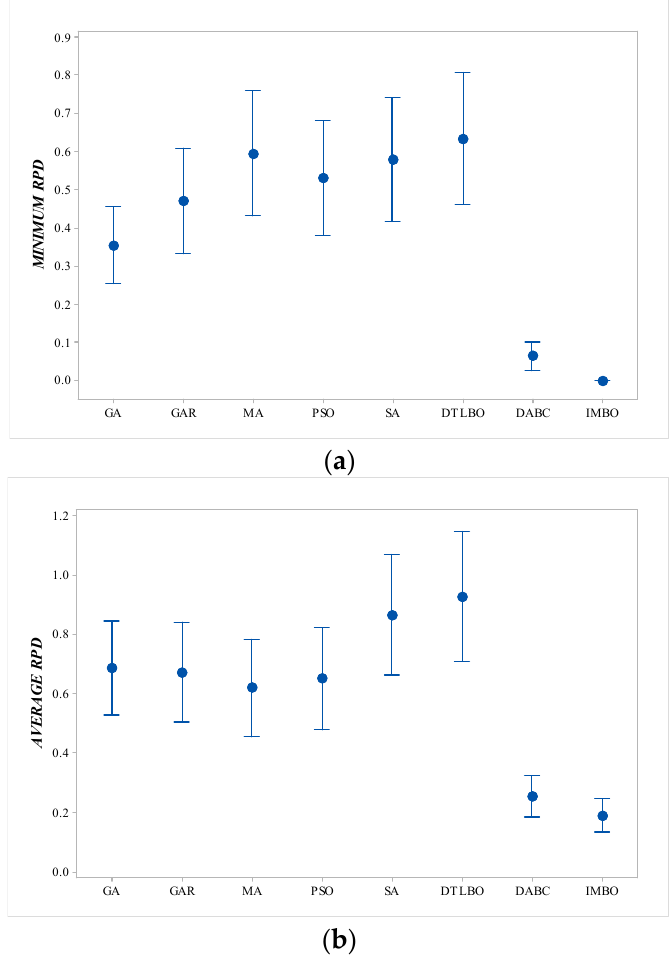
Figure 6. Means plots and 95% confidence intervals regarding minimum RPD or average RPD when ρ = 10. ( a ) The value of minimum RPD by algorithms; ( b ) The value of average RPD by algorithms.